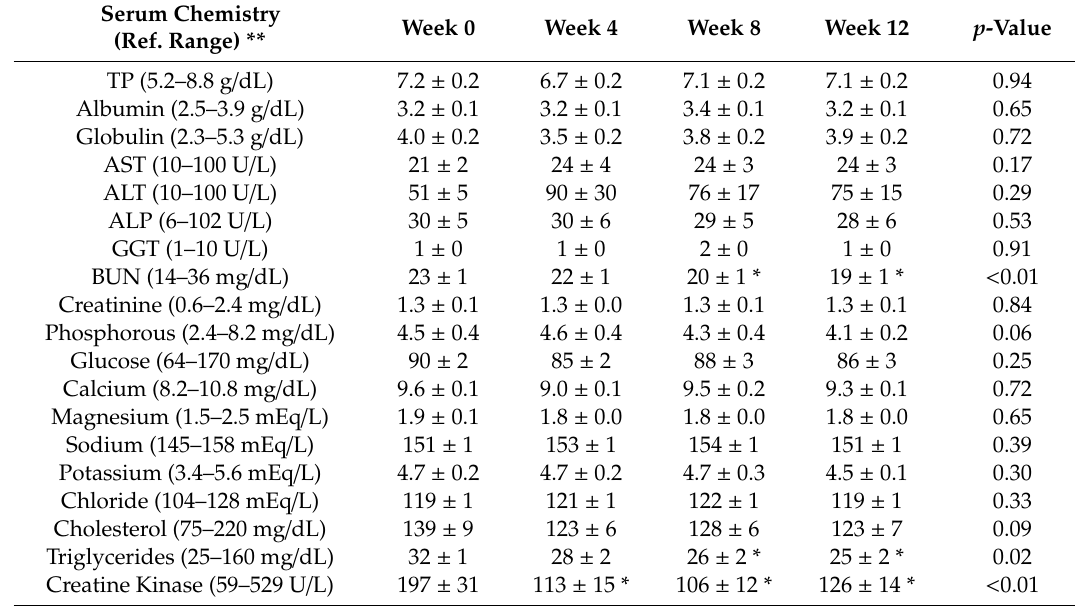
Table 6. Cat (n = 8) mean and SEM of serum chemistry parameters immediately prior to (week 0), 4 weeks, 8 weeks and 12 weeks of an oral 2 mg / kg CBD dose twice daily using a CBD-rich hemp product. Serum